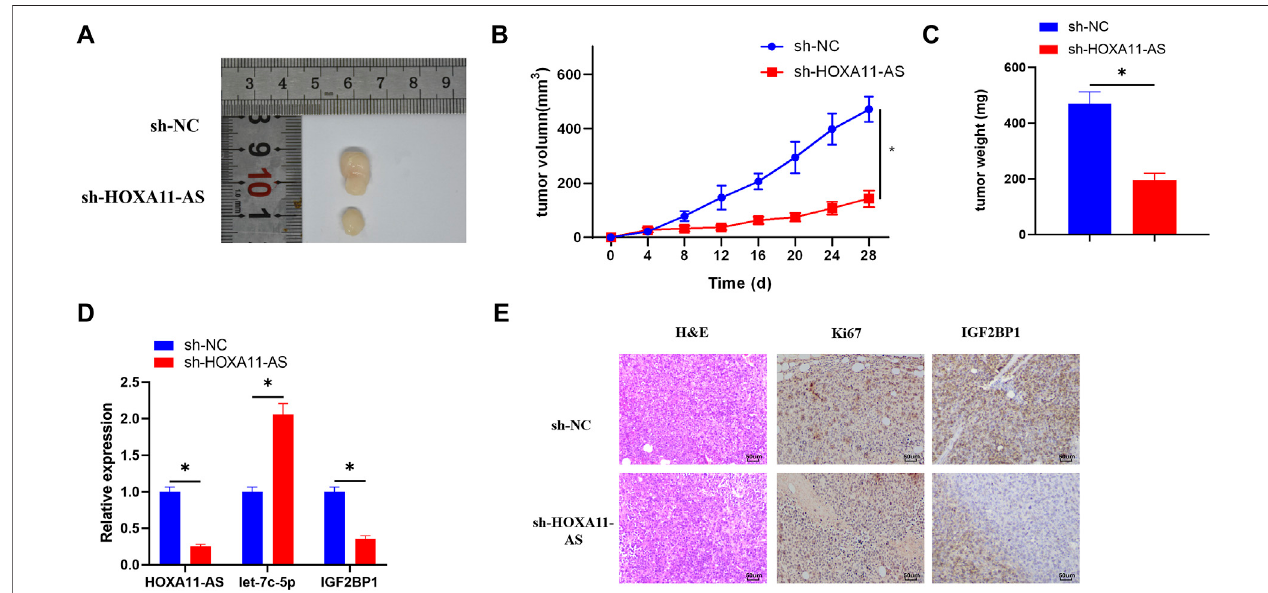
FIGURE 6 | HOXA11-AS facilitates LUAD cell growth in vivo via mediating the let-7c-5p/IGF2BP1 axis in mice. (A) Tumor condition in the HOXA11-AS inhibited group and the control group. (B) Growth curve of the tumors in mice. (C) Weight of the tumors was recorded. (D) qRT-PCR assay was conducted to assess the expression of HOXA11-AS, let-7c-5p, and IGF2BP1 in tumor tissue of mice. (E) By performing immunohistochemical analysis, expression of Ki67 and IGF2BP1 was determined (×400); * p <